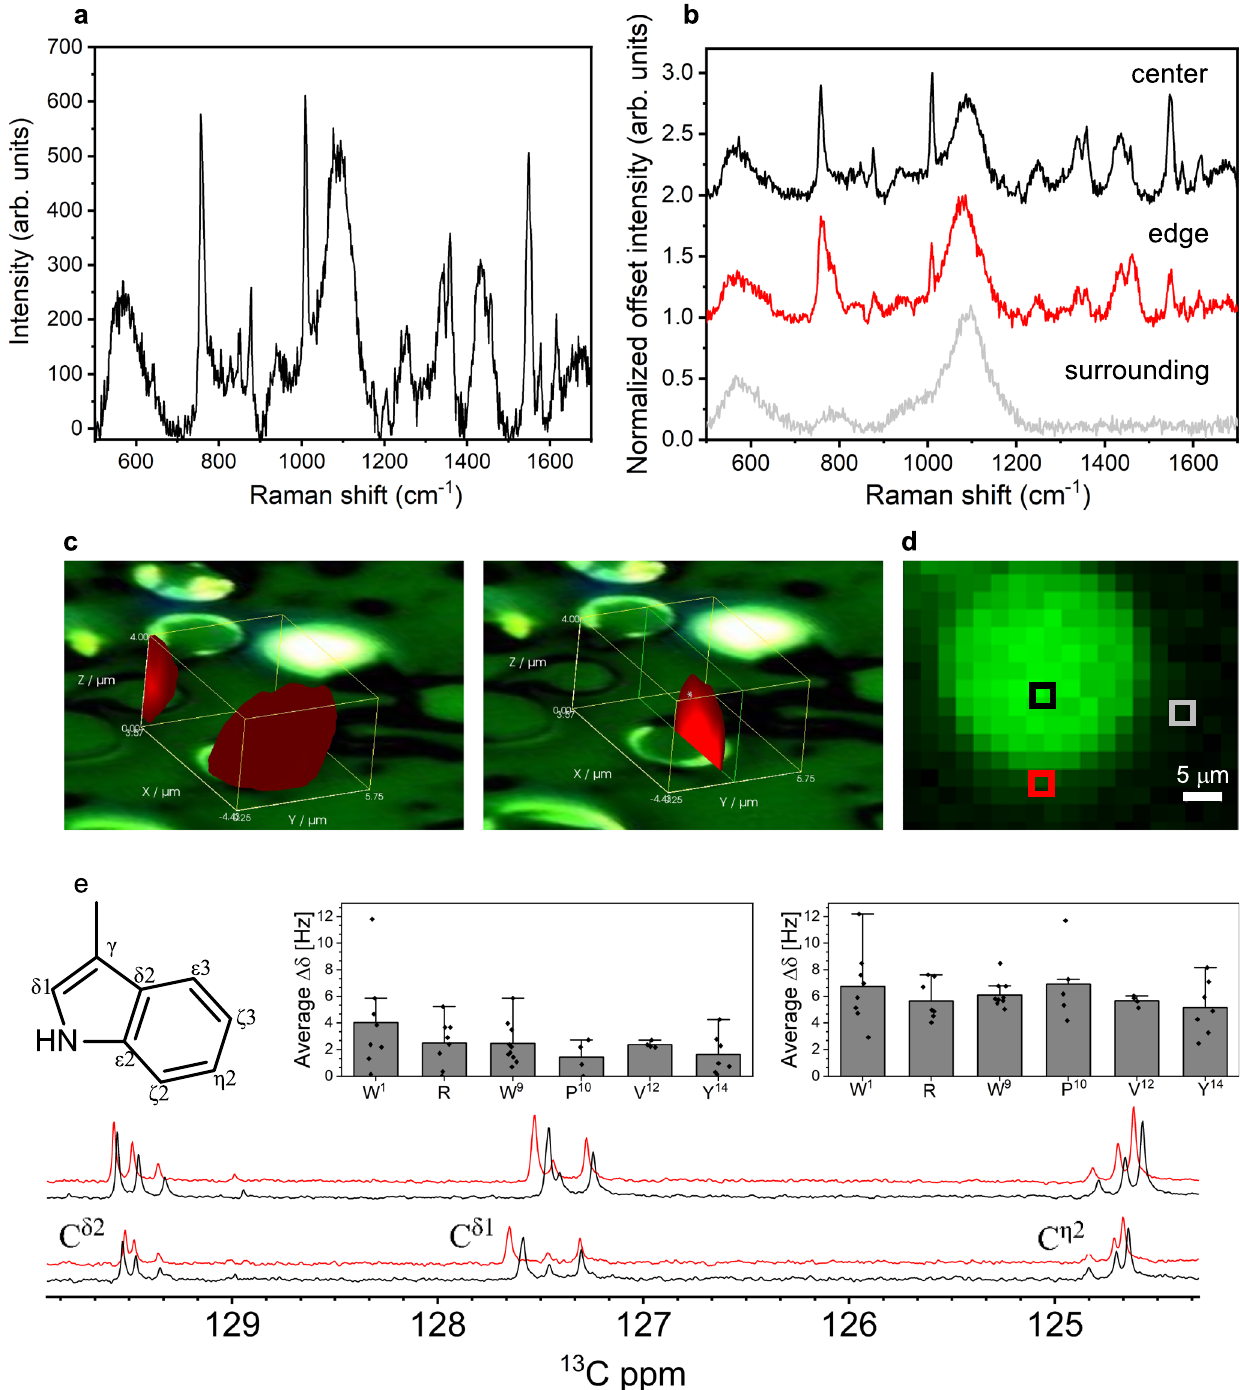
Fig. 5| Molecularlevelanalysis of droplet formationby using Ramanand NMR spectroscopy.a Raman spectrum obtained from averaging solution Raman map. b Normalized Raman spectra taken from 3 different spots of the 2D false color image: droplet center (black), droplet edge (red) and the droplet surrounding (light grey). The large peak at 1100cm − 1 originates from the glass background.